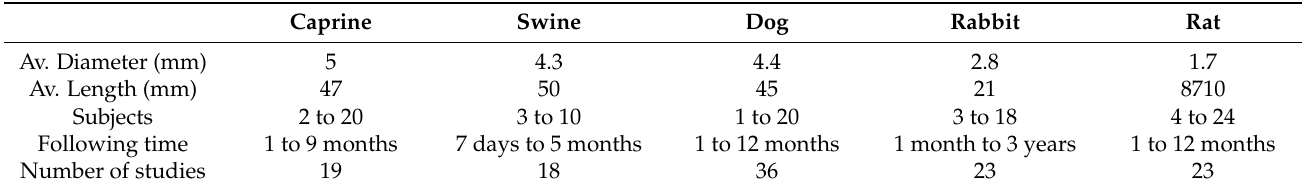
Table 1. Vascular graft features of the analyzed pre-clinical animal models. Caprine Swine Dog